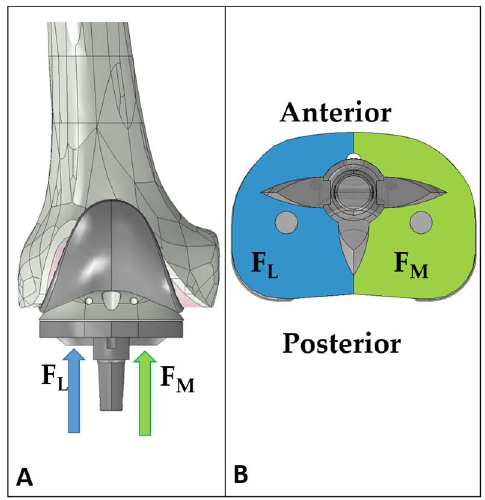
Figure 1. Load conditions applied to the model, ( A ) frontal view, reporting the direction of the forces applied; ( B ) distal view, reporting the area used for the applied force. FL = lateral force (in blue), FM = medial force (in green).